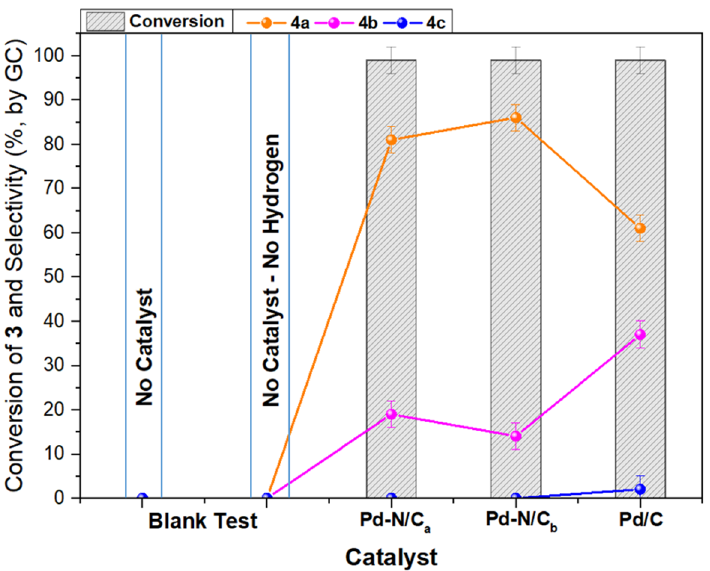
Figure 6. Catalysts screening in the reductive amination of furfural. Reaction conditions: 3 (0.1 M in methanol), catalyst (50 mg), 50 °C, 30 bar H 2 , flow rate (0.3 mL min − 1 ). Conversion and selectivity were determined by GC.